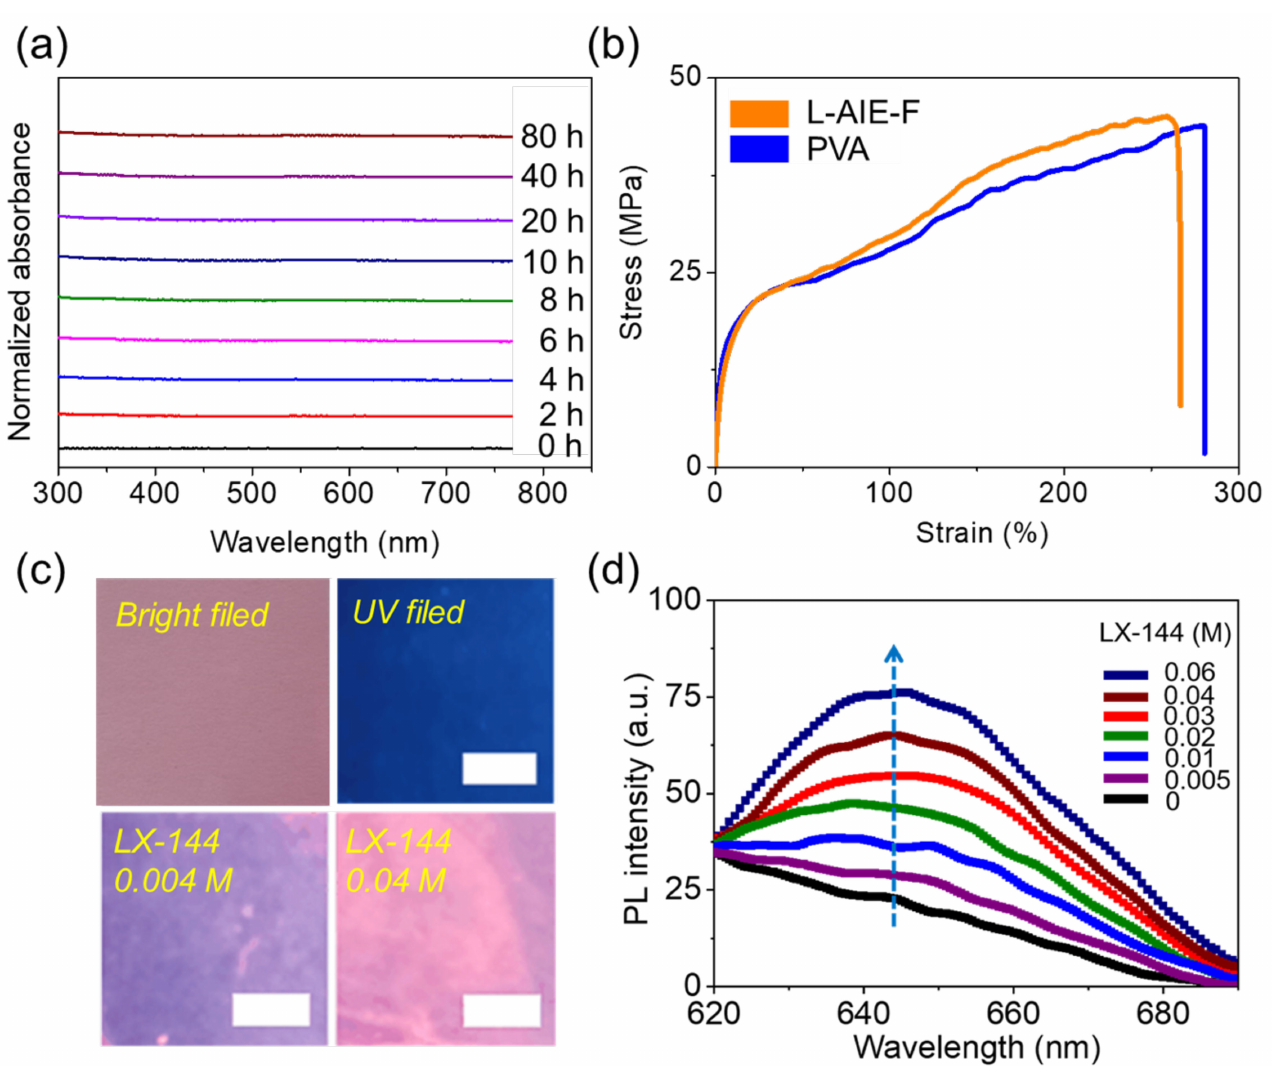
Figure 3. ( a ) In situ measurement of the absorbance of THF (10 mL) in the presence of L-AIE-F (2 × 2 cm) for different periods of time; ( b ) tensile strength of L-AIE-F and PVA; ( c ) images of L-AIE-F under bright field ( upper left ), UV field ( upper right ), UV field in the presence of 0.05 M LX-144 ( lower left ), and UV field in the presence of 0.4 M LX-144 ( lower right ); ( d ) fluorescence emission of L- AIE-F in the presence of different concentrations of LX-144, with an excitation wavelength = 365